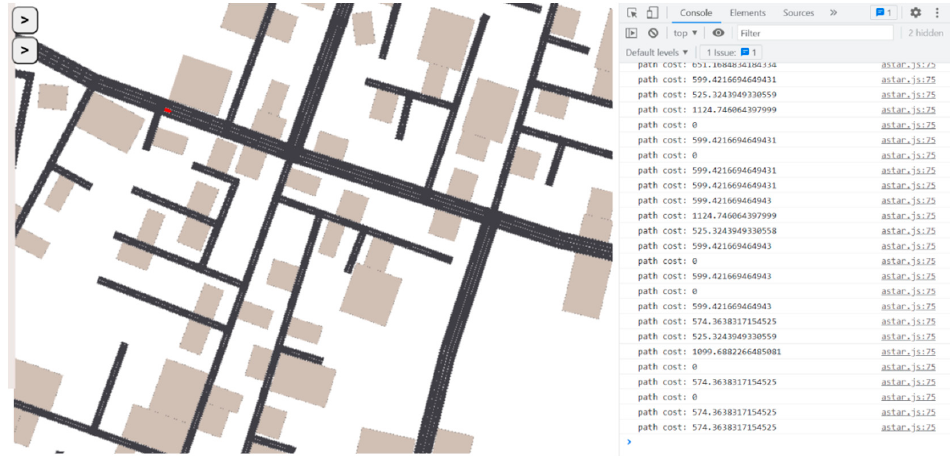
Figure 2. Simulator Interface.